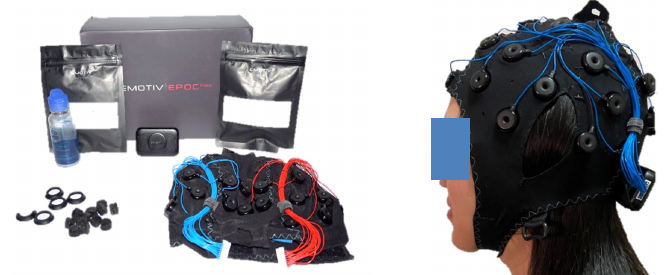
Figure 1. EPOC Flex 32-channel wireless EEG device.